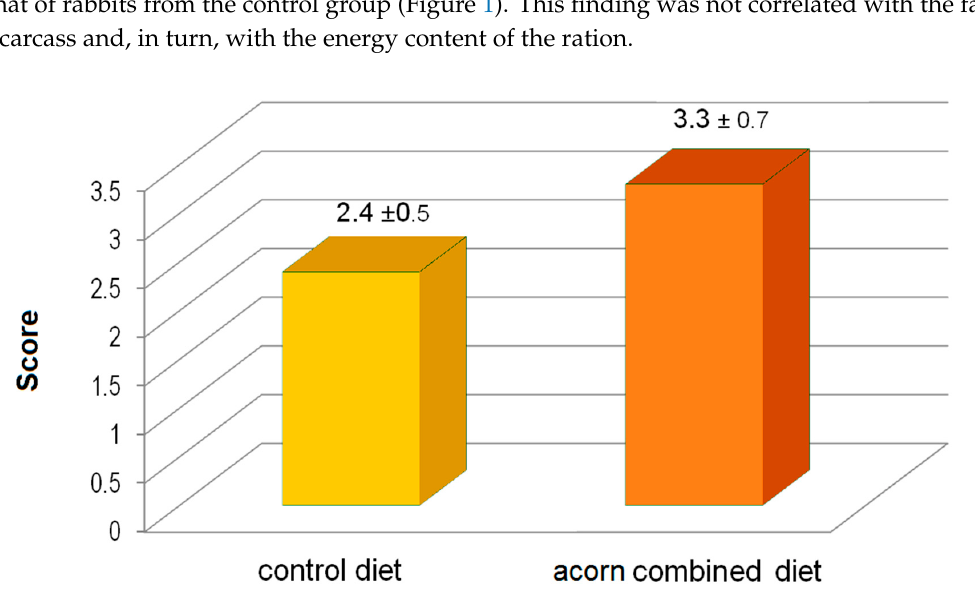
Figure 1. Histograms of scores (1–5 point scale) of a panel test of roasted meat from musculus quadriceps femoris assessed for aromatic properties by independent trained experts. Values are expressed as mean values ± standard error.